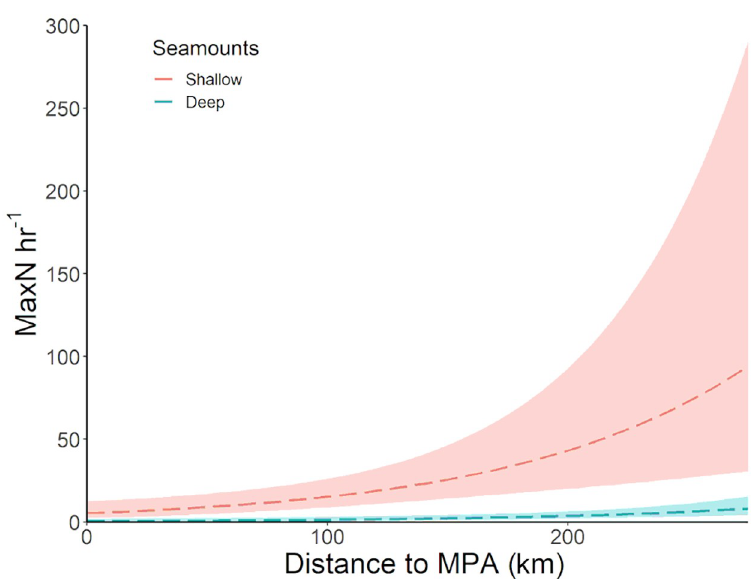
Fig 6. Graphical results from the top-ranked AICc generalized linear model for large pelagic species (LPS) relative abundance (MaxN hr -1 ). Representation of the relationship between MaxN hr -1 of LPS and distance to nearest MPA (Cocos or Galapagos Islands) at shallow ( < 400 m) and deep ( > 400 m)